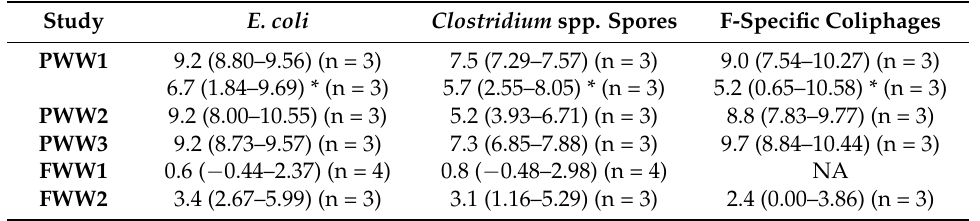
Table 2. Mean and range of total log 10 removals of water treatment processes in pilot scale (PWW) and full-scale (FWW) waterworks. n = number of samples E.